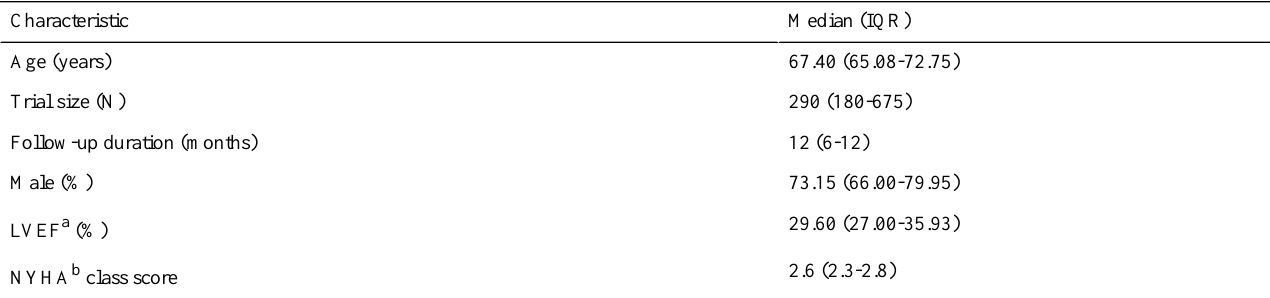
Table 2. Participants’characteristics in 26 randomized controlled trials included in the subgroup